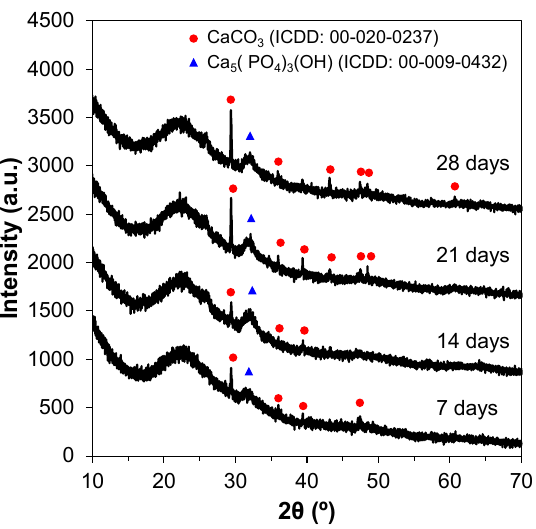
Figure 7. XRD patterns of powders (calcined at 600 °C) immersed in SBF from 7 to 28 days.